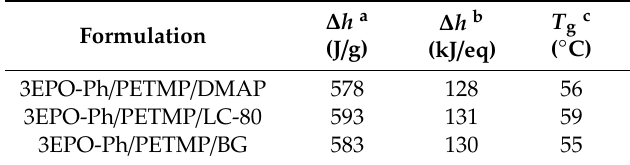
Table 1. Reaction enthalpies and T g s determined by DSC of the formulations 3EPO-Ph/PETMP with different catalysts studied.